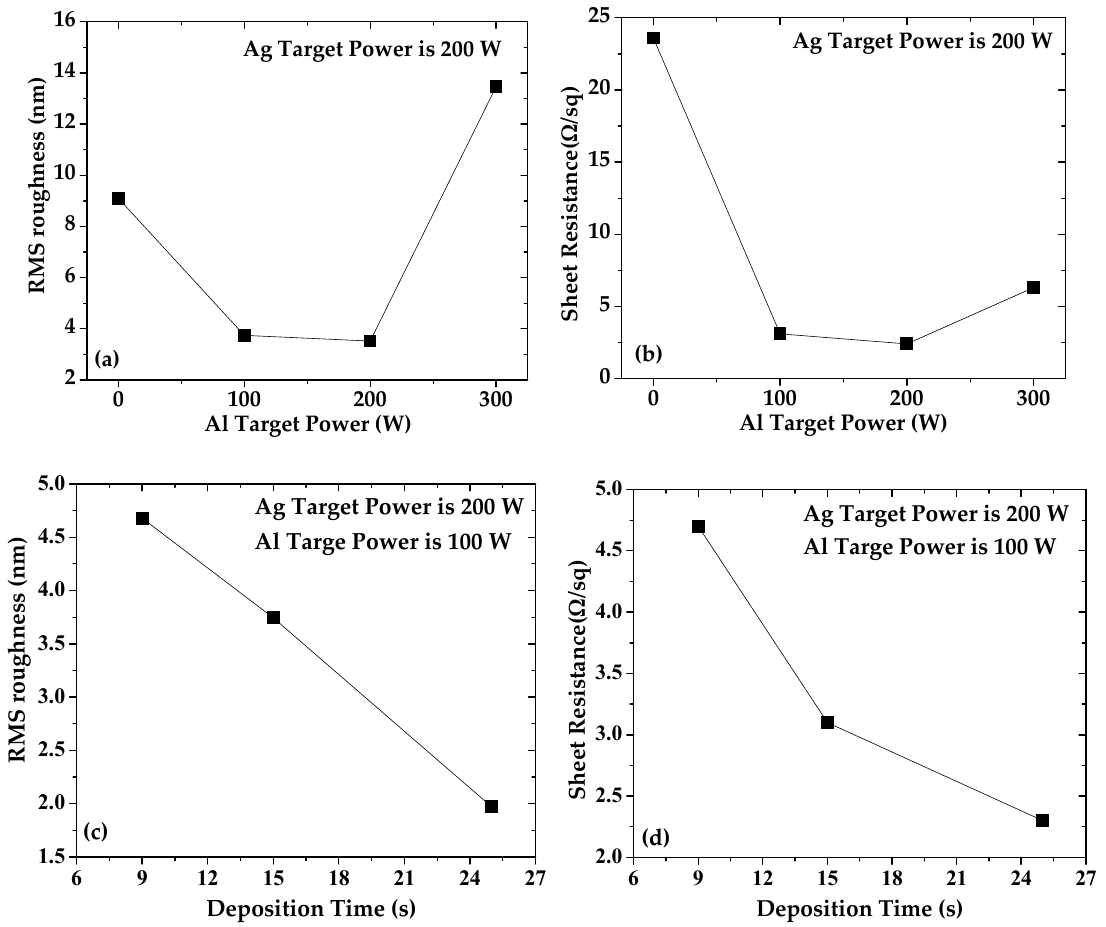
Figure 2. AFM images of each sample. ( a ) Sample 1, ( b ) sample 2, ( c ) sample 3, ( d ) sample 4, ( e ) sample 5, ( f ) sample 6, ( g ) substrate. The scan parameters are: scan size is 5.000 μ m, scan rate is 1.001 Hz, number of samples is 256, image date is height, x is 1.000 μ m/div and z is varied from 80 to 150 nm/div.